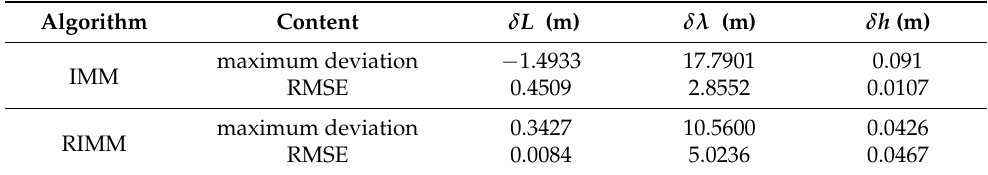
Table 8. Position error parameters for the two algorithms.